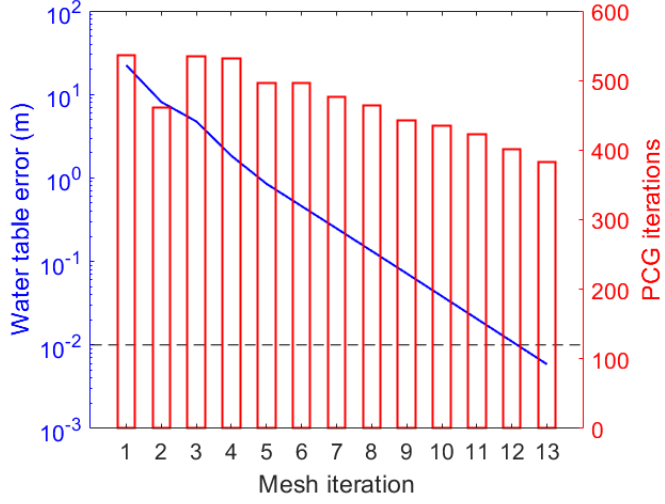
Figure 12. Performance of the adaptive mesh iteration for the three-dimensional problem. The water table error decreases with a rate greater than a linear trend. The bars show the number of linear iterations at each outer iteration. Thirteen mesh iterations were sufficient to achieve accuracy with a 10 −2 m closure criterion.